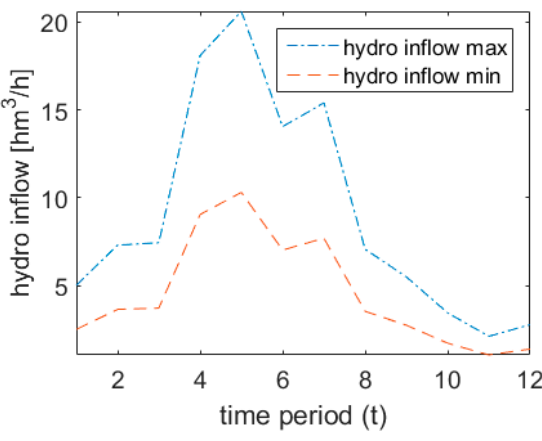
Figure 5. Hydro inflow range.